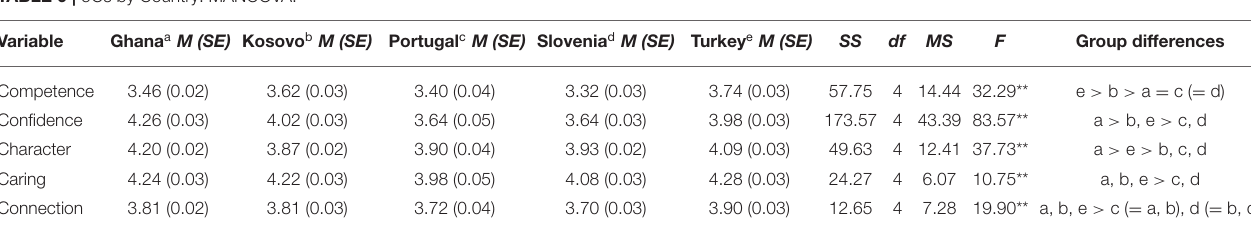
TABLE 6 | 5Cs by Country: